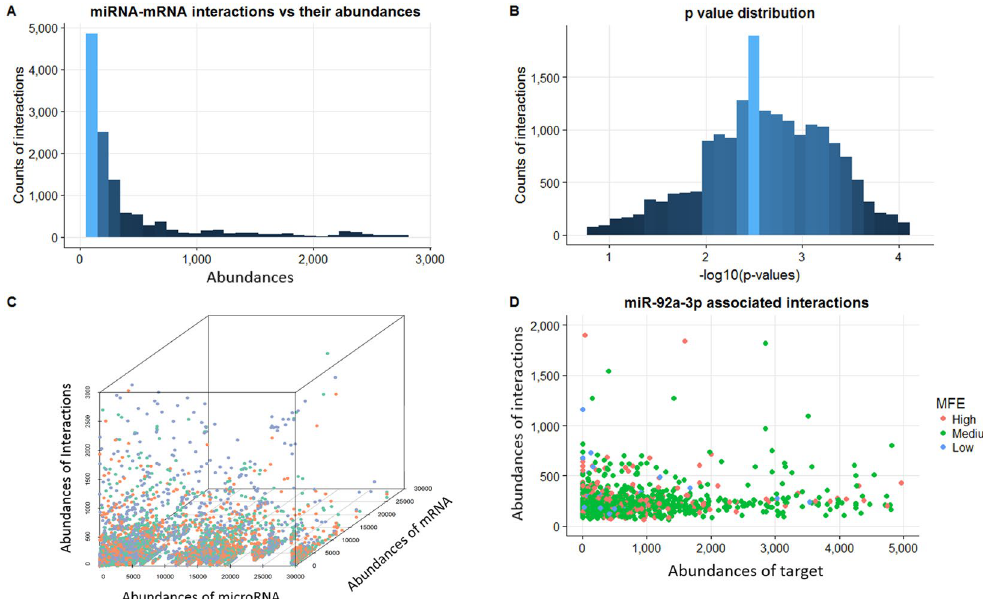
Figure 2. Overview of the interactions detected by the CLASH analysis. ( A ) Distribution of the miRNA-gene interactions (y-axis) with respect to their abundances (x-axis). ( B ) Distribution of the corrected p-values of each interaction from Binomial test for quality filtering. ( C ) Projection of each interaction based on the abundance of the corresponding miRNA (x-axis), mRNA (y-axis), and interaction (z-axis). ( D ) The relationship between the abundances of each miR-92a-3p interaction and the corresponding mRNA. The colored points indicated the three levels of binding affinities based on MFE values: High (red, [ − 31.2, − 21.8]], Medium (green, [ − 21.8, 12.3]), and Low (blue, [ − 12.3, −